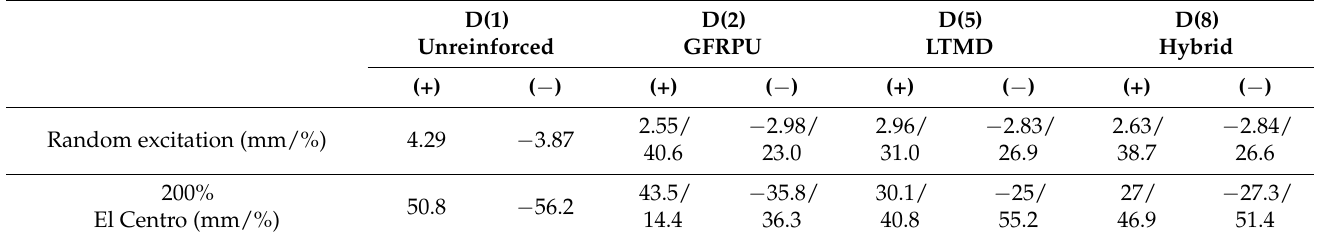
Table 6. Summary of dynamic responses under random excitation and 200% El